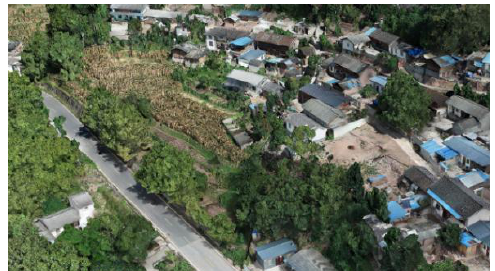
Figure 7 . Detailed display of the refined 3D scene model. The DEM difference analysis results are shown in Fig.